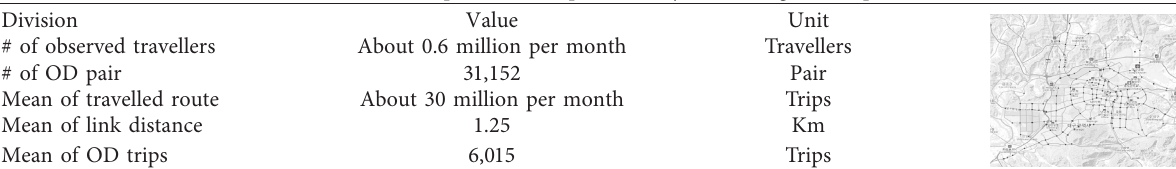
Table 2: Data description and empirical study area (Daegu metropolitan area).